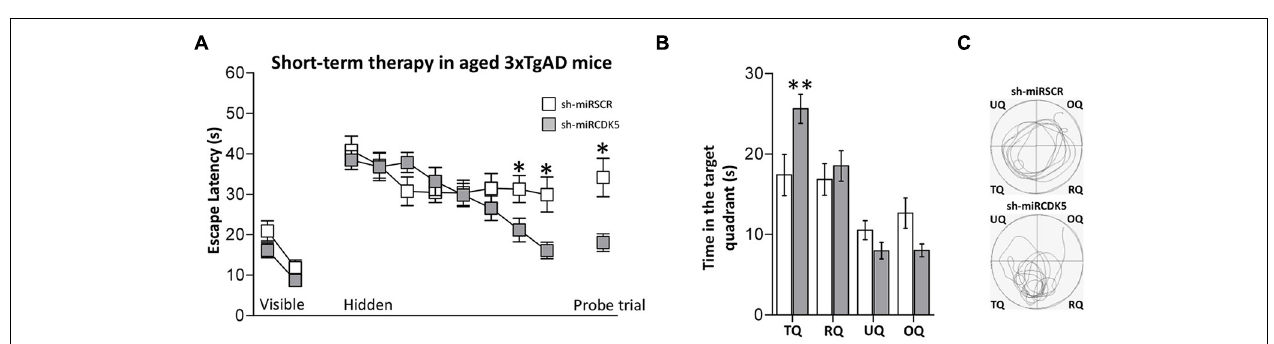
* p < 0.05, ** p < 0.01. (D) Steady-state levels of CDK5 and AT8 decreased after injection of shCDK5miR in hippocampal lysates of aged littermate mice injected with shSCRmiR (white bars) and shCDK5miR (gray bars).There was no statistical significance between shSCRmiR and shCDK5miR in AT100, AT180, PHF1 andTau5 levels. Representative blots are shown.Tubulin was used as loading control. Densitometry quantification was done, RU = relative units. n = 4. * p < 0.05, ** p < 0.01. (E) CDK5 kinase activity evaluated by histone phosphorylation in long-term treatment in control mice. A band corresponding to the IgG heavy chain was detected and used as loading control. Densitometry quantification was done. n = 3, * p < 0.05, ** p < 0.01.